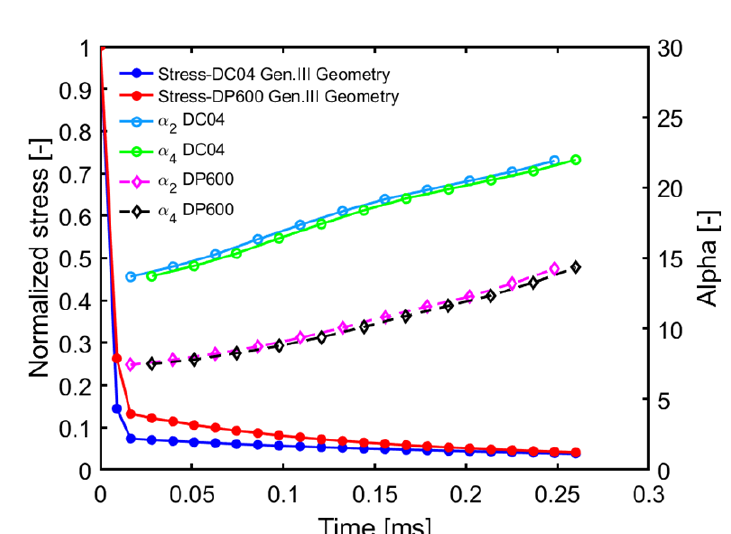
Figure 7: Reduction of the normalized (based on incident stress amplitude) stress amplitude during the tests and the corresponding α -value in beam 2 and 4 for DC04 and DP 600